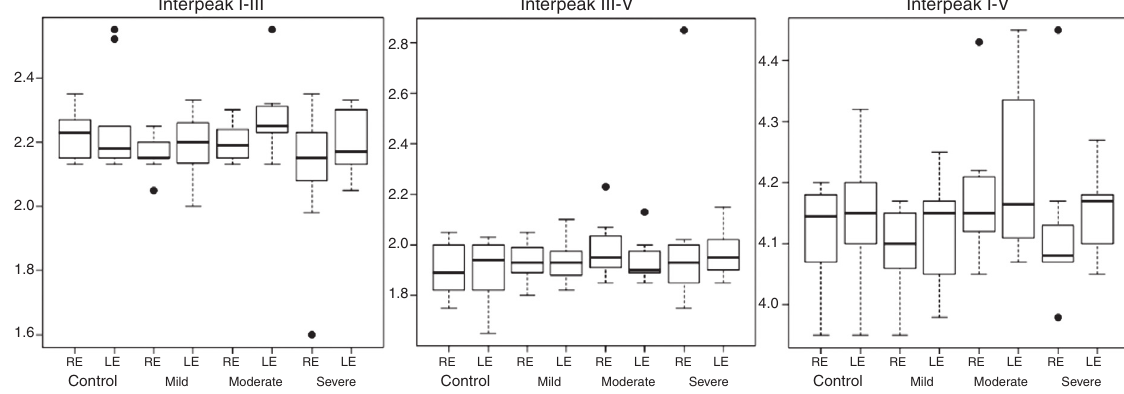
Figure 2 Interpeaks I---III, III---V and I---V (in milliseconds) according to the side of the ear and